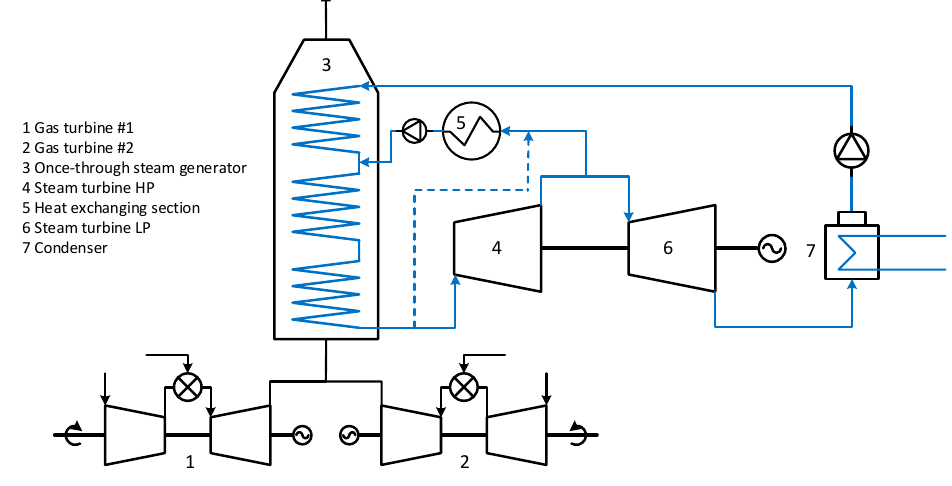
Figure 8. Layout of the extraction steam turbine cycle.